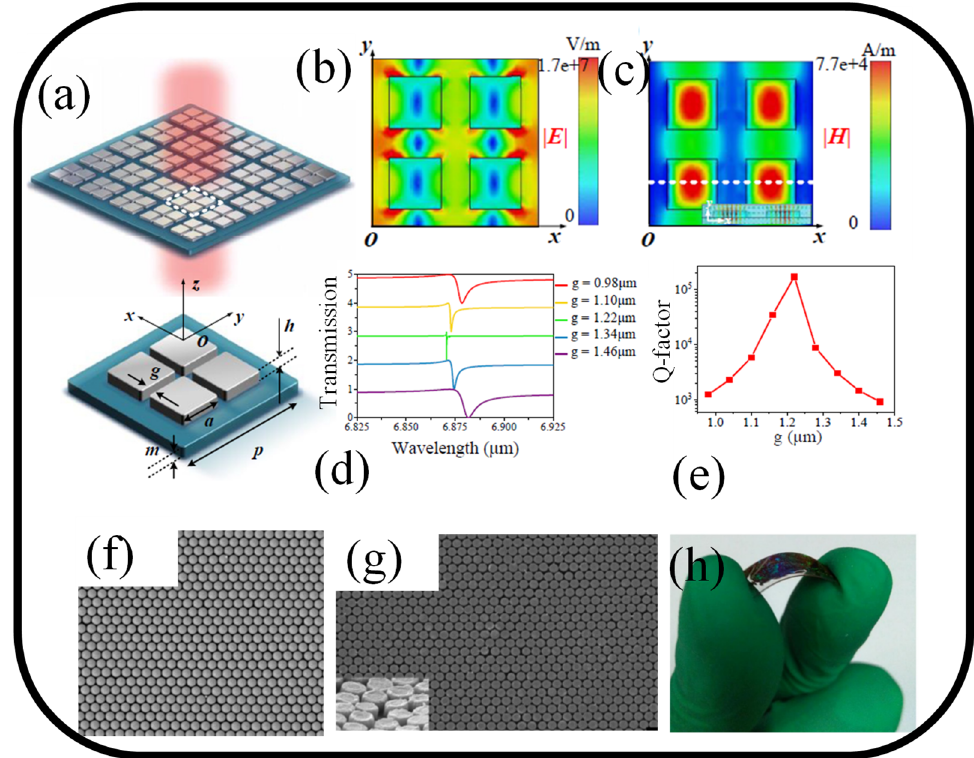
Figure 6. ( a ) Schematic representation of the symmetric MS [133], ( b ) E-field distribution [133], ( c ) Magnetic field distribution [133], ( d ) transmission spectrum of the MS [133], ( e ) Q-factor [133]. ( f ) SEM images of ( f ) PS spheres that self-assembled [141], ( g ) Si cylinders that were produced using RIEs. Both exhibit a regular hexagonal lattice. The tilted view (60°) of a specifically selected faulty area is represented in the inset in ( g ) to better illustrate the spatial morphology [141], and ( h ) the final MS sample shows its adaptability